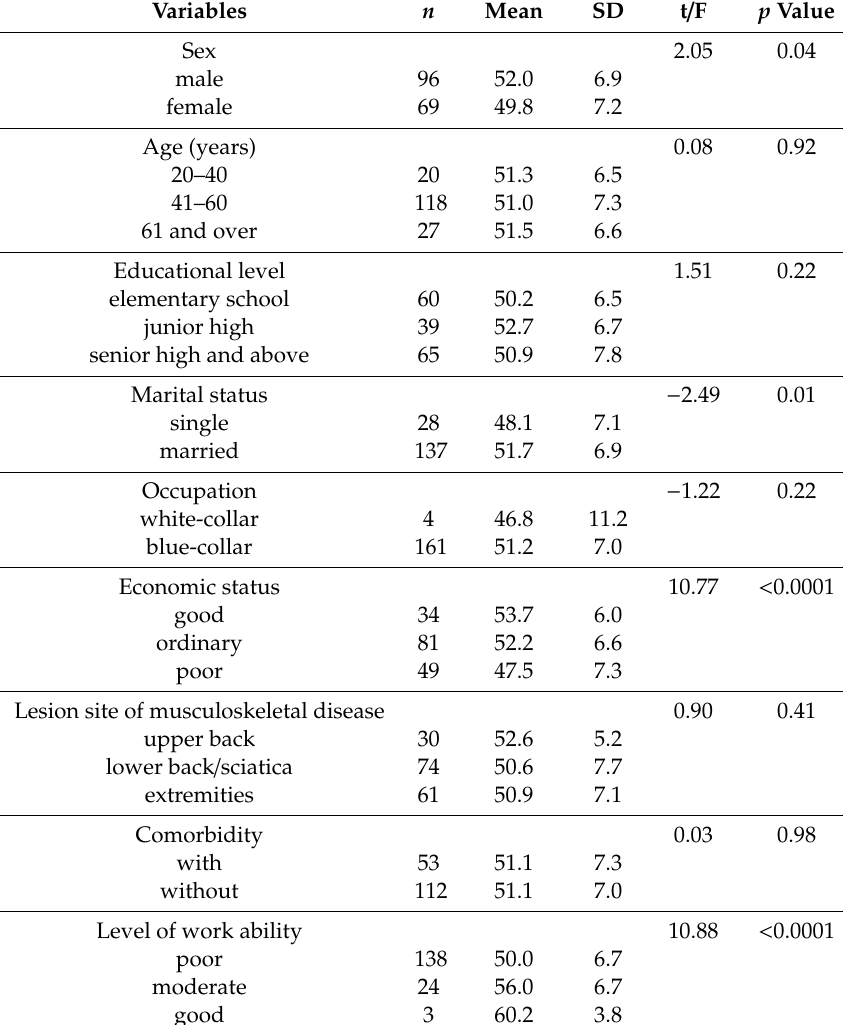
Table 2. Comparing the overall quality of life by the characteristics of the